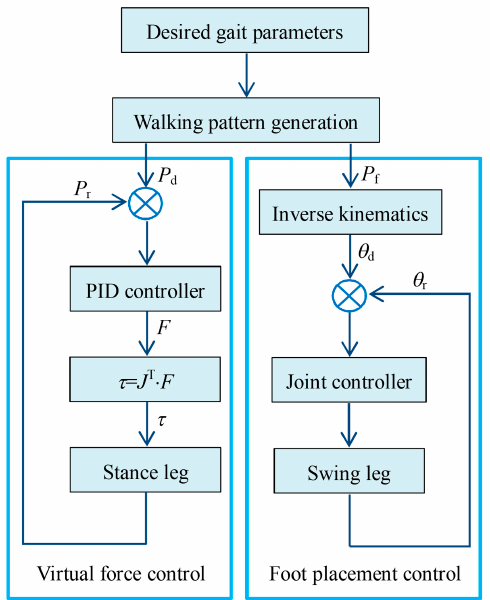
Figure 4. The hybrid walking control scheme. The virtual force control is applied on the stance leg, while the foot placement control is applied on the swing leg.